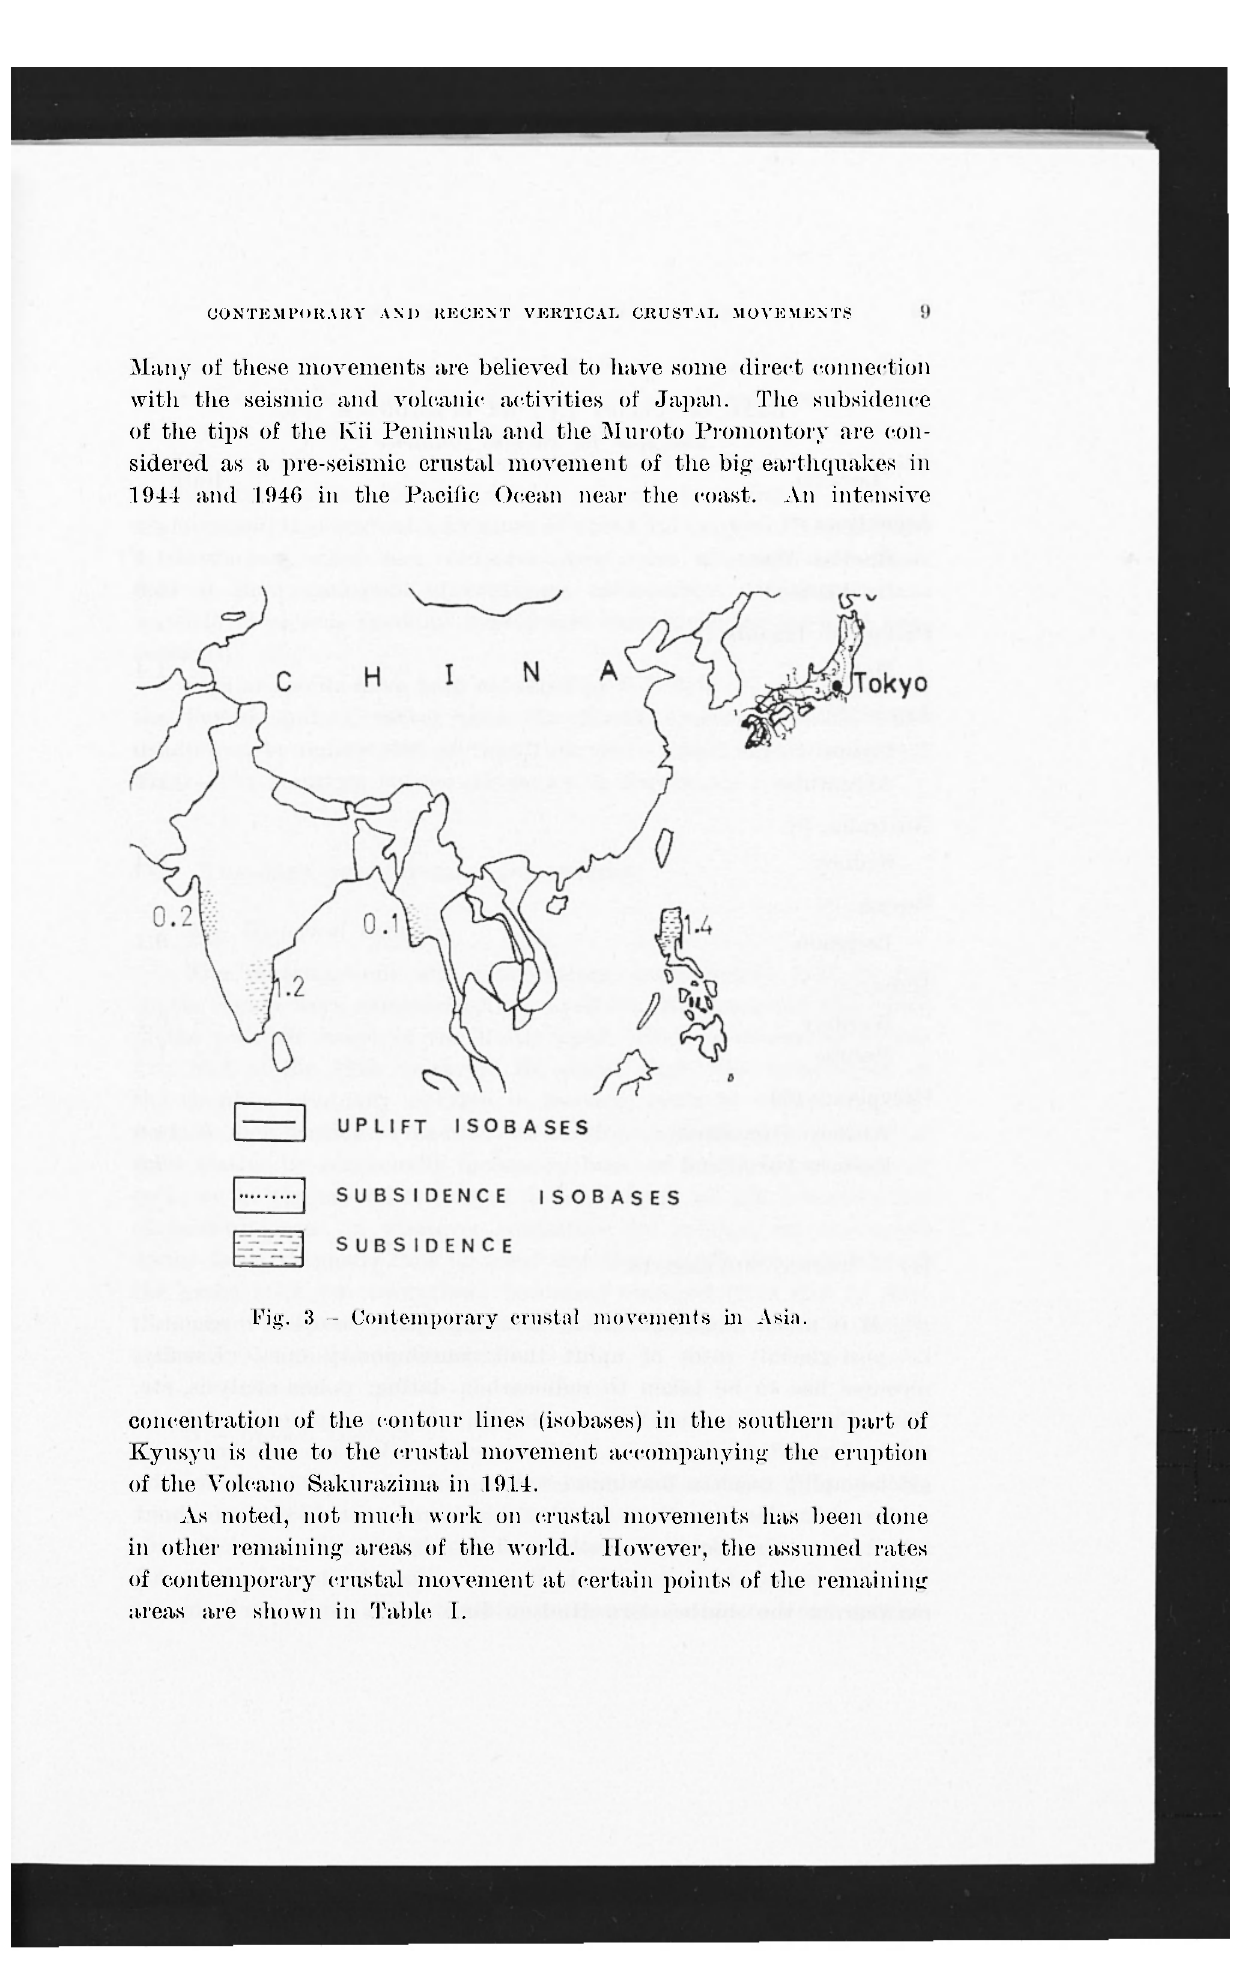
Fig. 3 - Contemporary crustal movements in